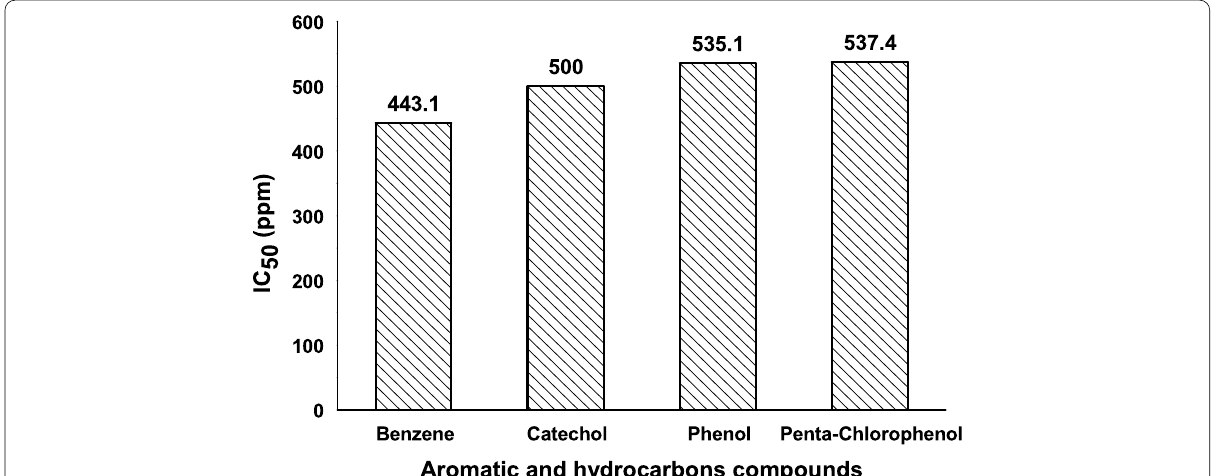
Fig. 10 IC 50 of aromatic and hydrocarbon compounds on the bioluminescence of Vibrio sp.